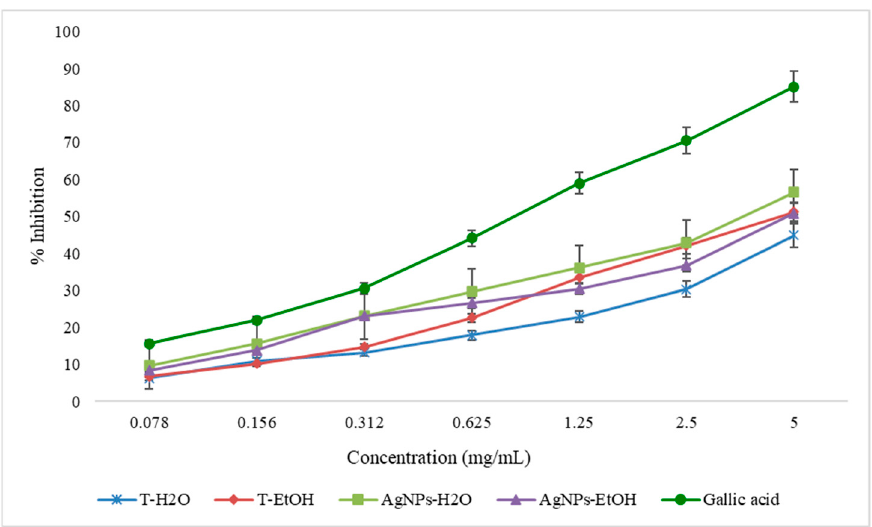
Figure 16. Graphical representation of the 15-LOX inhibition capacity (%) of extracts and of their corresponding AgNPs solutions, compared to gallic acid.